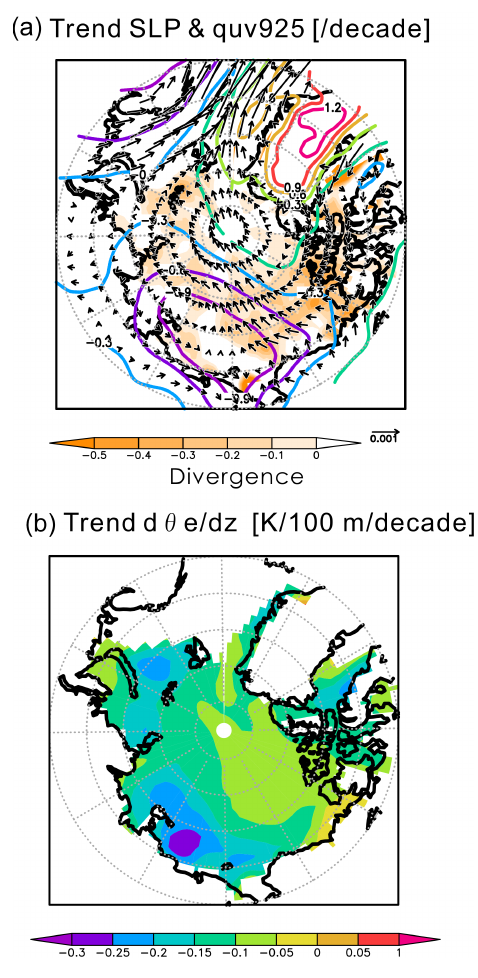
Figure 10. (a) Simulated linear trend in sea level pressure (SLP, contours), moisture flux at 925hPa (quv925, vectors), and con- vergence(shade). The unit of the moisture flux trend is (kgkg − 1 ) (ms − 1 ) decade − 1 . (b) Simulated linear trend in the lapse rate of the equivalent potential temperature (d θe/ d z : θe indicates the equiva- lent potential temperature; z indicates geopotential height) between the surface and σ = 0 . 9. The unit for the lapse rate of the equiv- alent potential temperature is K(100m) − 1 decade − 1 . The values were averaged over all ensemble